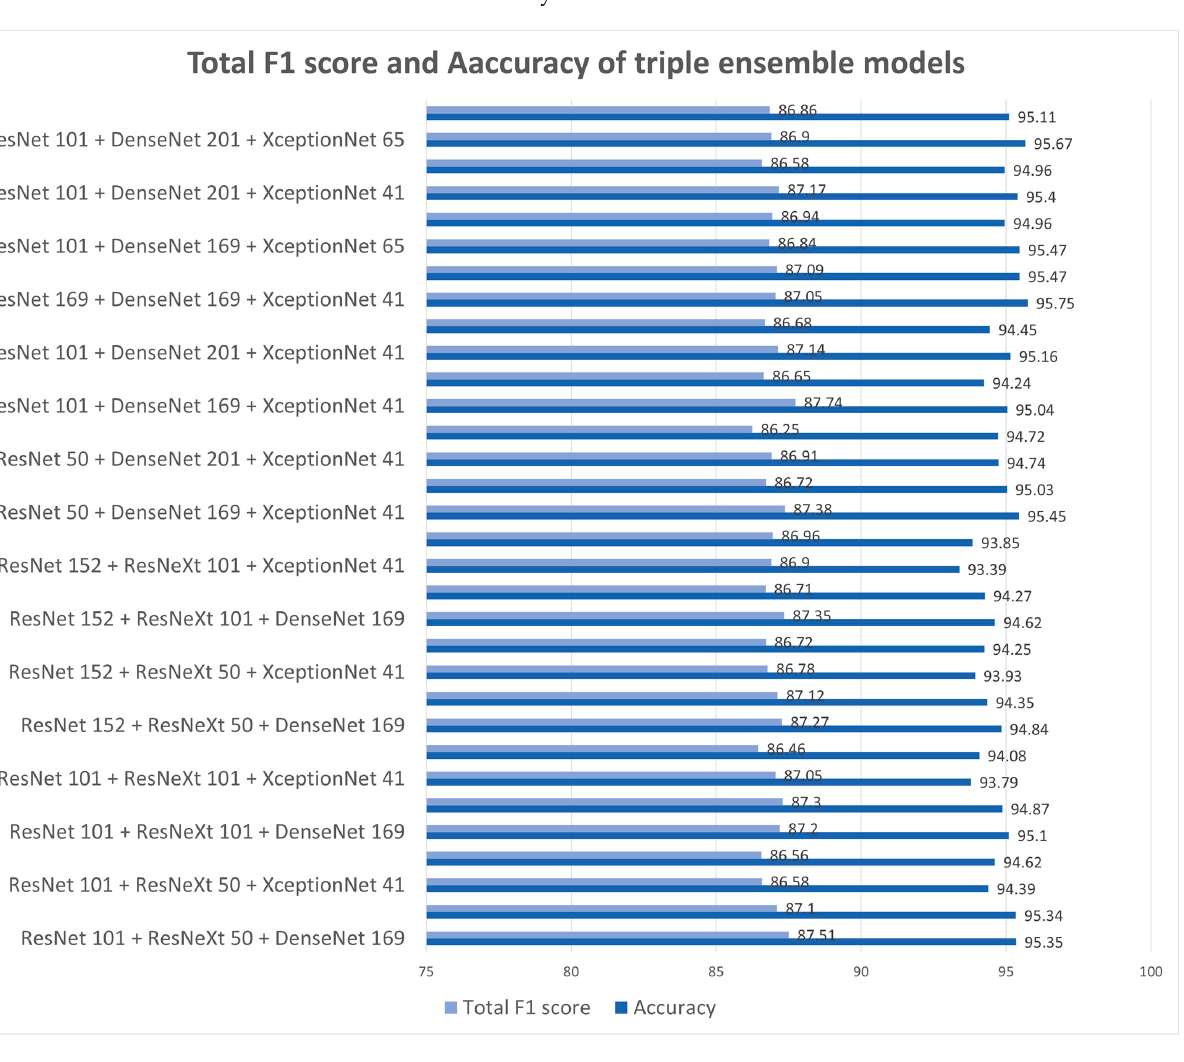
Figure 5. F1 score and accuracy of the triple ensemble model with data augmentation. Table 10. F1 score of a single network model with data